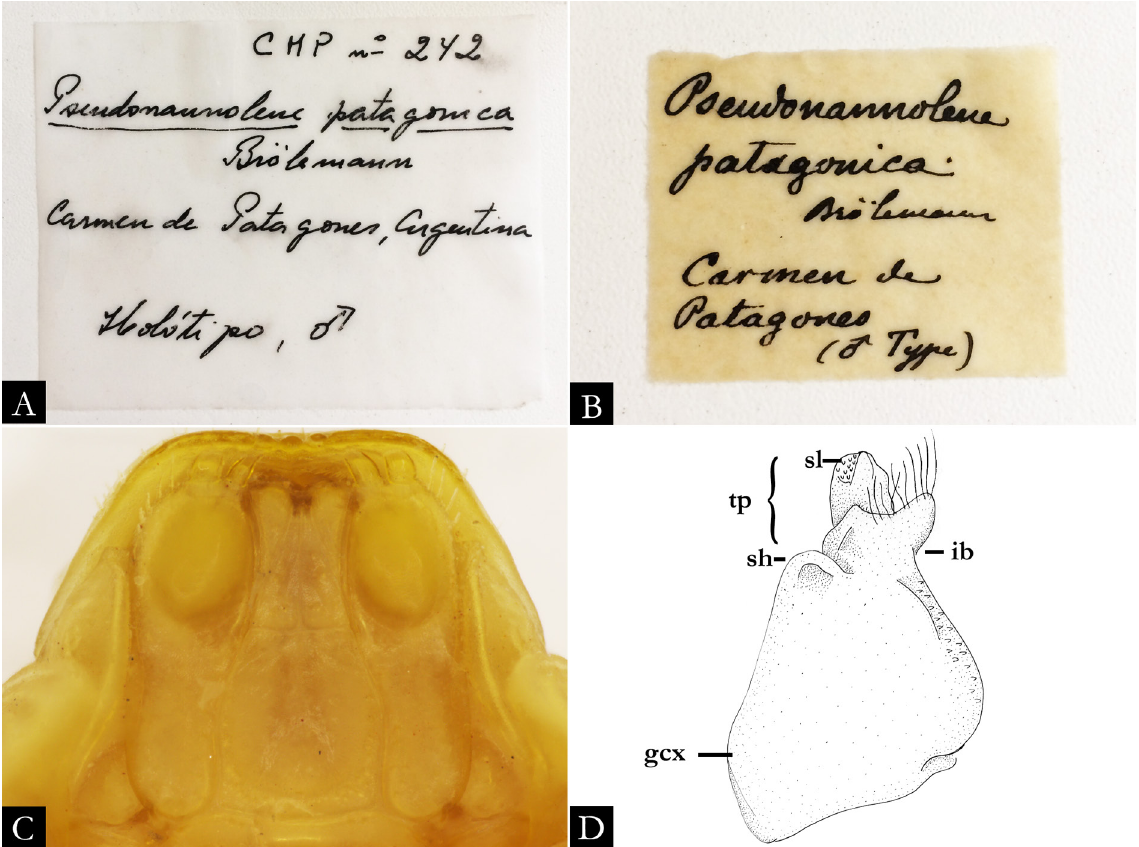
Fig. 108. Pseudonannolene patagonica Brölemann, 1902, holotype, ♂ (MZSP 0242). A–B . Original label of type material. C . Gnathochilarium in ventral view. D . Schematic drawing of right gonopod in anal view (modified from Brölemann 1902a: fig. 164). Abbreviations: see Material and methods. Images not to